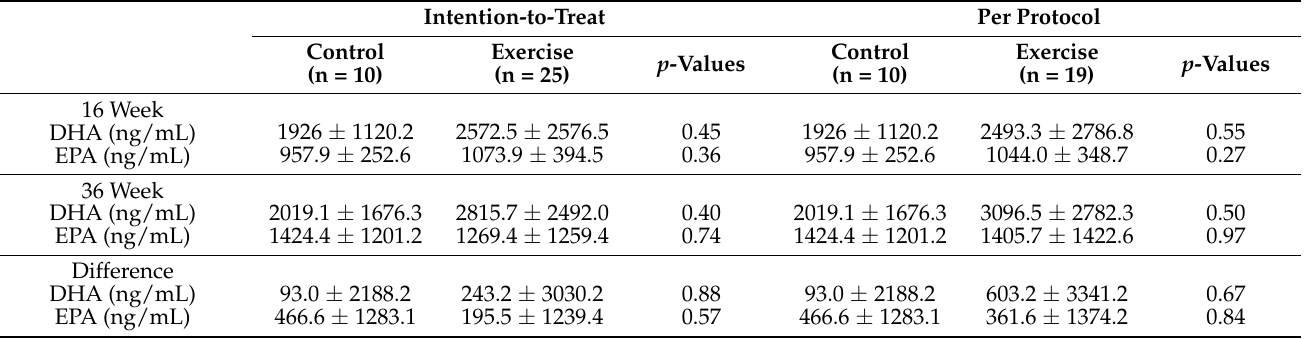
Table 2. Intention-to-treat and per protocol analysis of maternal DHA and EPA red blood cell concentrations between aerobic exercise and non-exercising